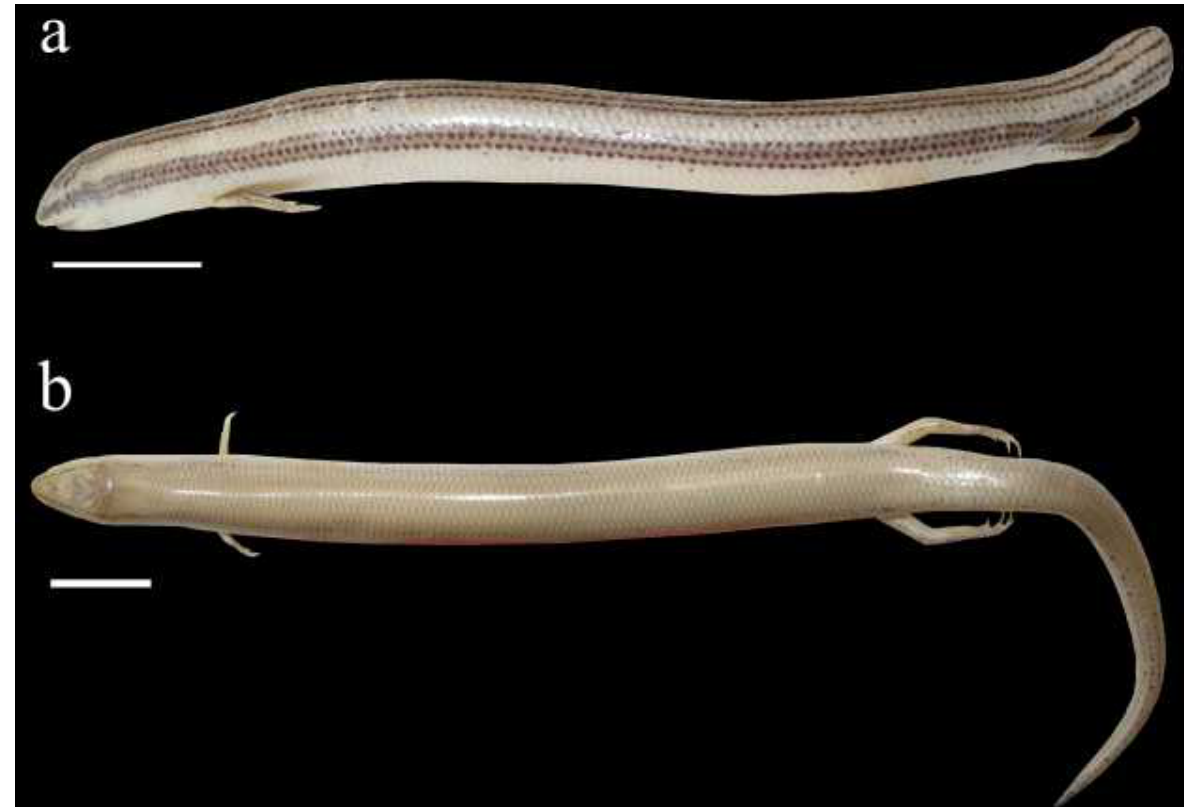
F IGURE 2. (a) Dorsolaterl view of an adult specimen of Ophiomorus brevipes (RUZM-SO14.01) with broken tail from Sarjou, Saravan County, and (b) dorsal view of an adult specimen of O. tridactylus (RUZM-SO13.01) from Beris-e Kohneh, Chabahar County, both in Sistan and Baluchestan Province, southeastern Iran. Scale bar = 1 cm. (Photo by Ali